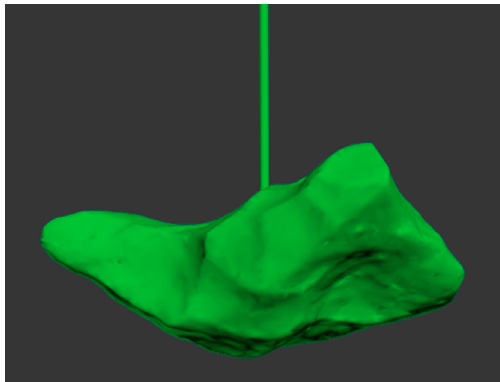
Figure 16. The three-dimensional model of the cave (h1).